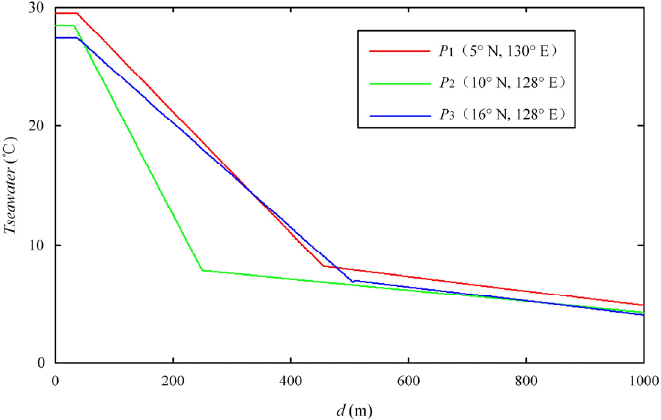
Figure 8. Variation of seawater temperature with depth at different positions.